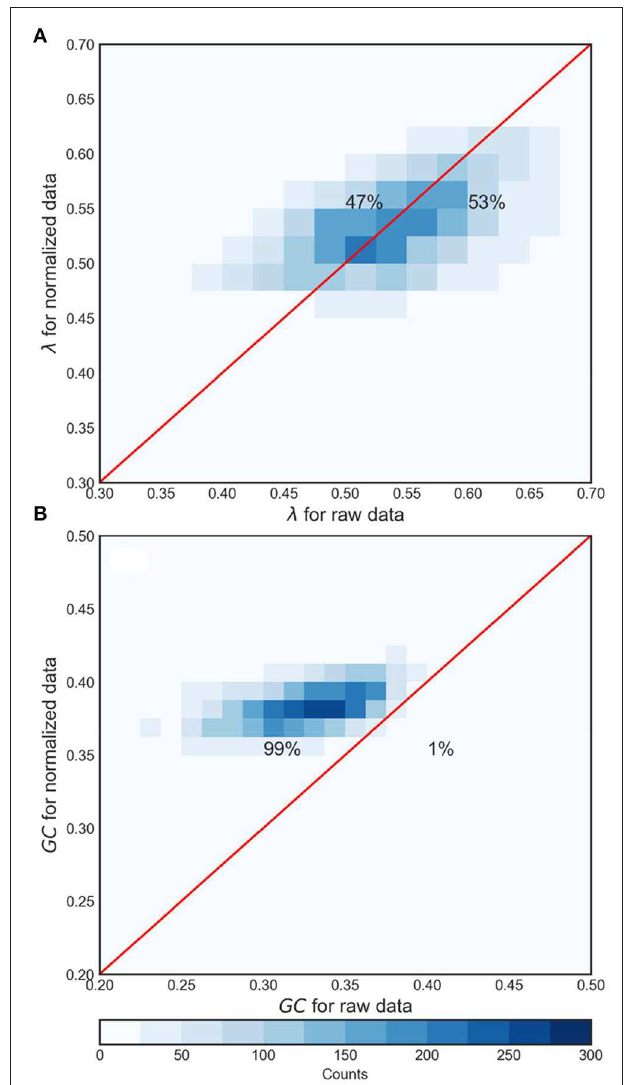
FIGURE 8 | Two-dimensional histogram depicting the comparison between metrics for normalized and raw streamflow time series. The metrics are pooled from all stations for all historical records. (A) Comparison of λ and (B) comparison of GC . As explained in the text, GC is more affected by normalization than λ , with higher values for the normalized data (99% of the data points favoring normalized data), indicating that normalization tends to result in more connected networks, hence, more linear